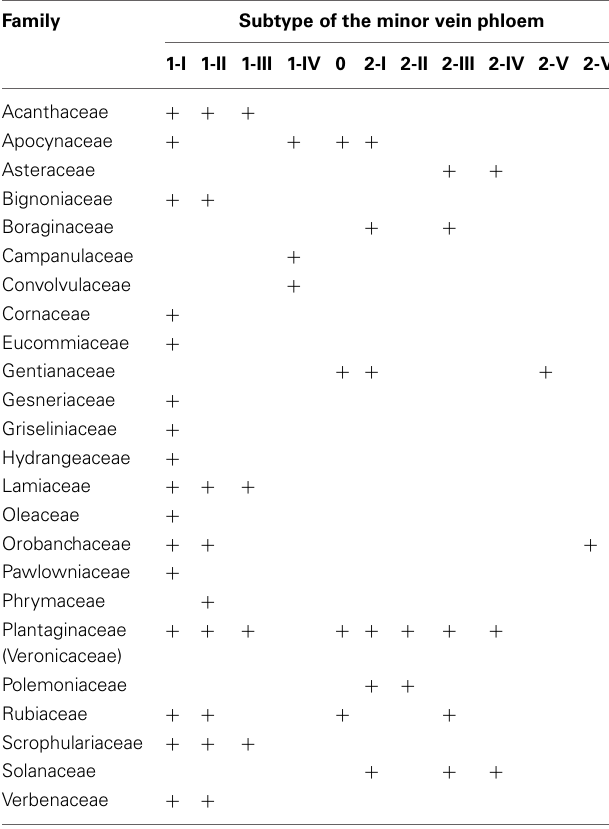
Table 3 | Distribution of minor vein phloem types and subtypes among the families of